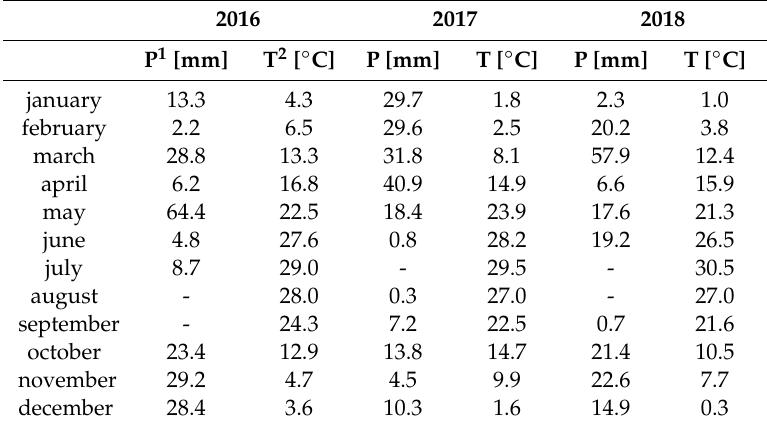
Table 1. Temperature and precipitations in Ghafurov region in 2016–2018.